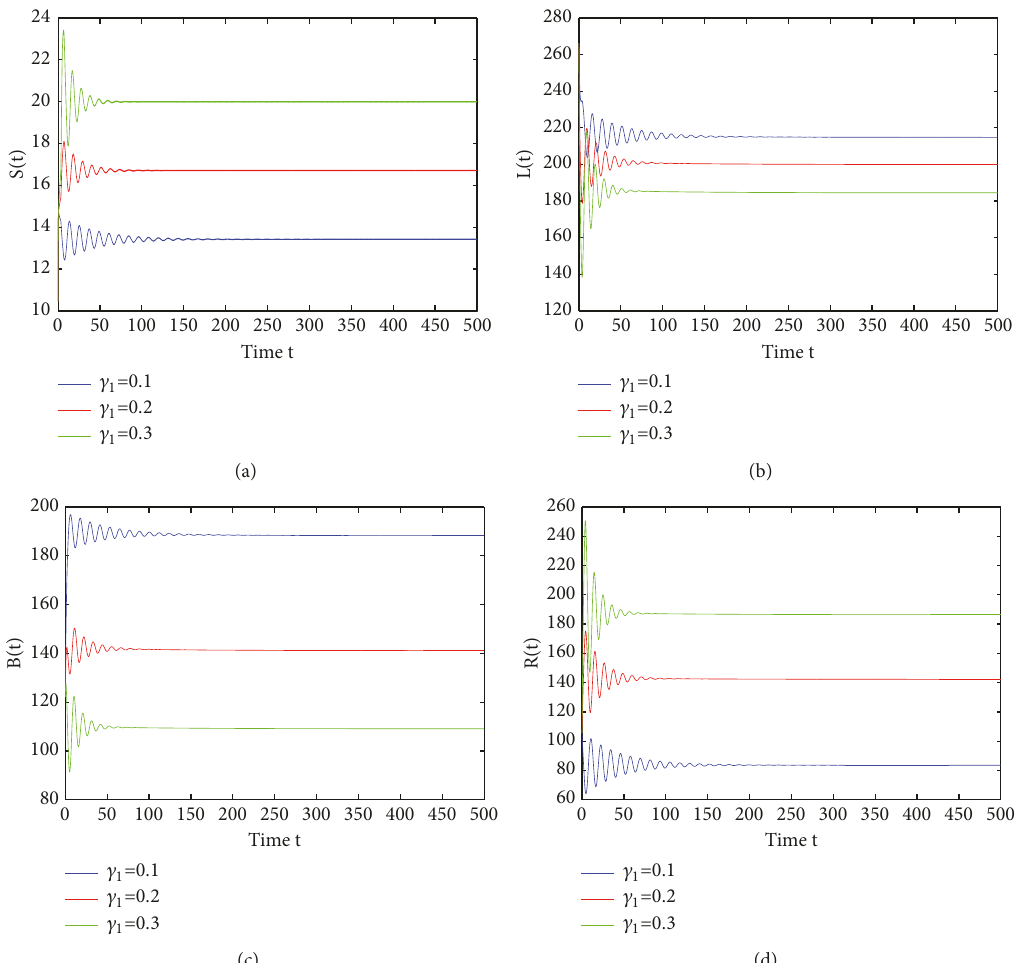
Figure 7: Time plots of 𝑆 , 𝐿 , 𝐵 , and 𝑅 for different 𝛾 1 at 𝜏 = 3.2575 . Rest of the parameters are taken as given in the